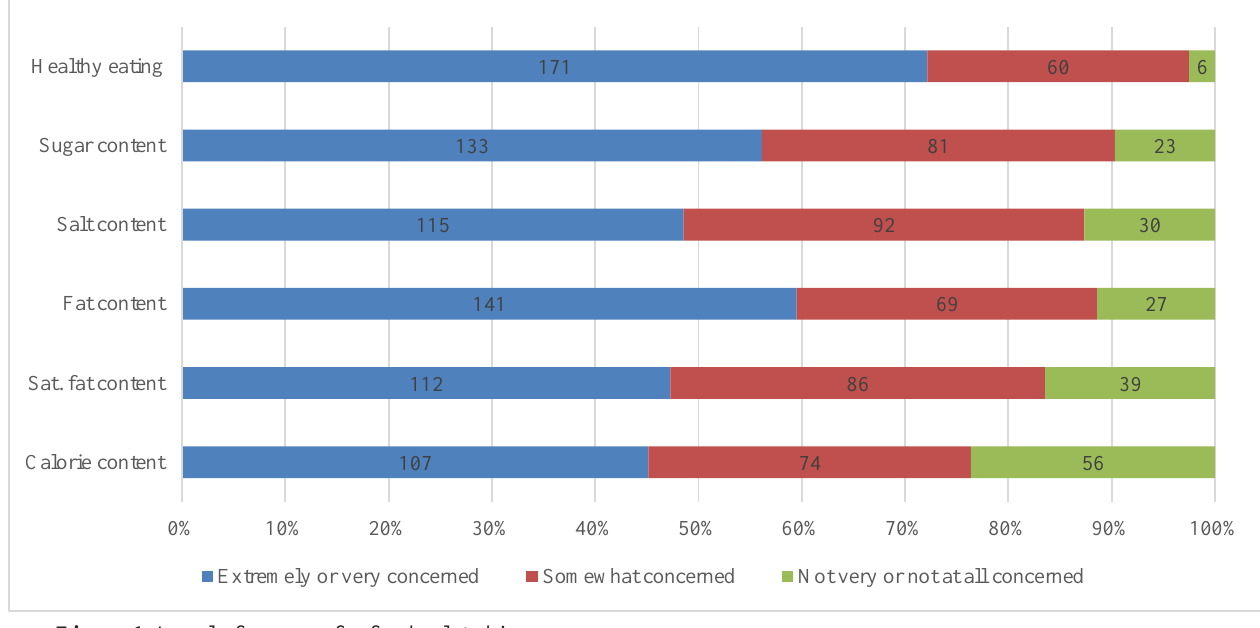
Figure 1. Level of concern for food-related issues